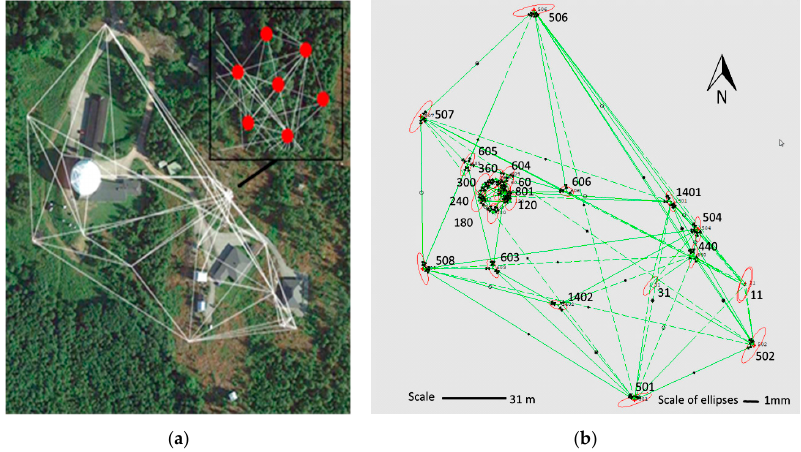
Figure 7. ( a ) Fundamental station Metsähovi, Finland, WGS84 (60.217301 N, 24.394529 E); with local tie network. ( b ) Network configuration with stations 11, 31 and 180, which define local tie vectors.